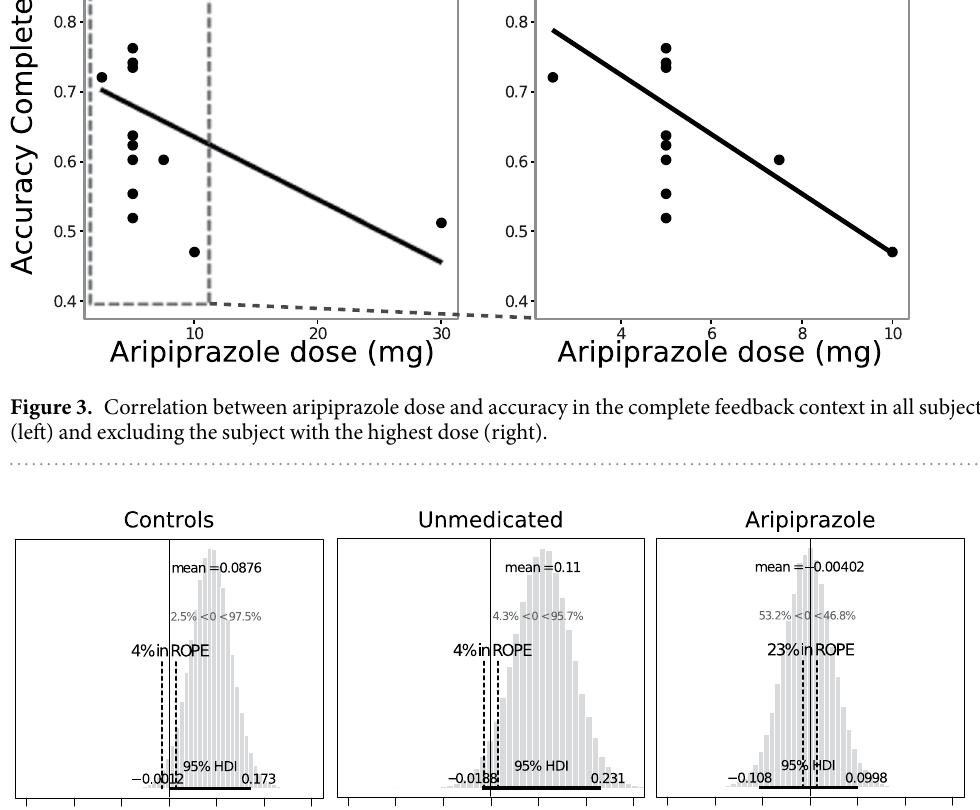
Accuracy (correct choice rate) Reaction time (seconds) Condition